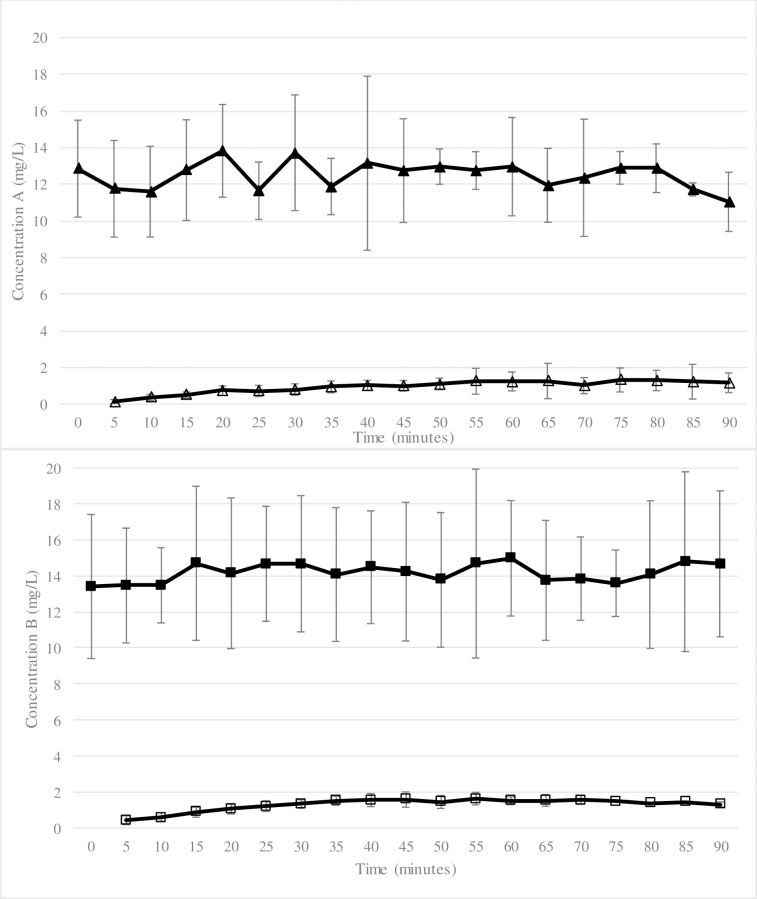
Mean Letermovir concentrations (Panel A) and mean Maribavir concentrations (Panel B) for all placentas. Panel A: Mean (± SD) maternal (full triangle) and fetal (empty triangle) concentrations of Letermovir (mg/L). Panel B: Mean (± SD) maternal (full square) and fetal (empty square) concentrations of Maribavir (mg/L).